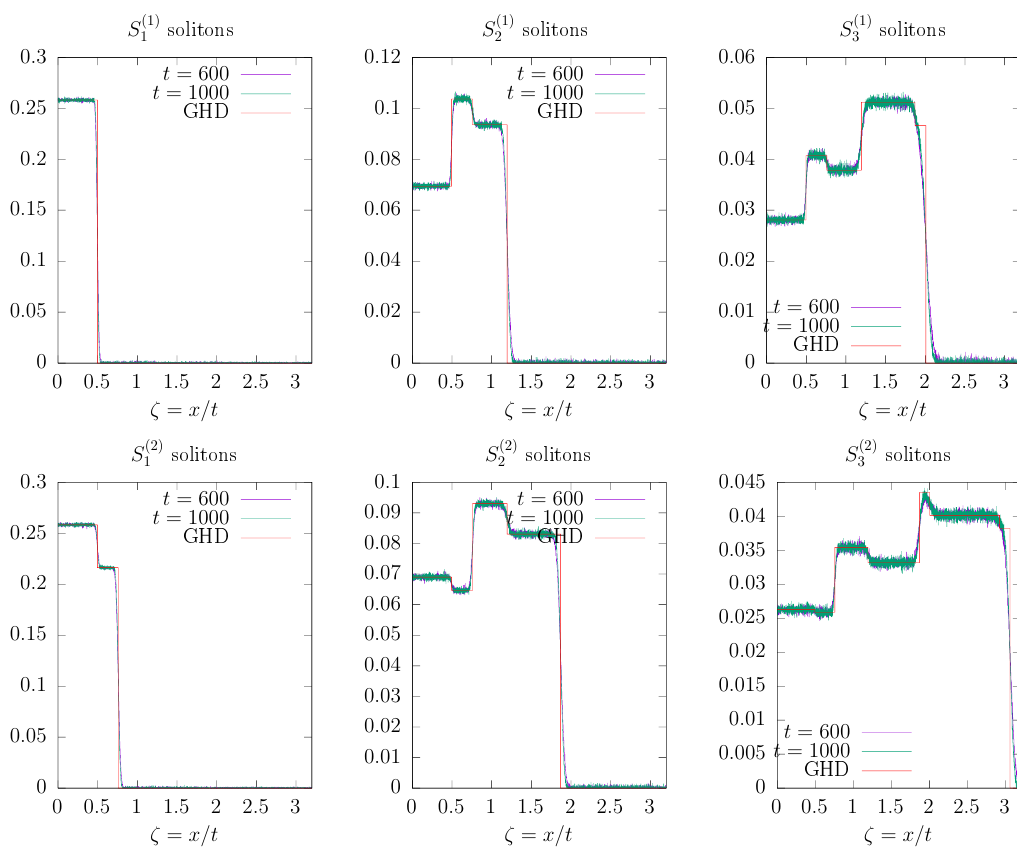
( a ) Figure 4: Numerical results for several S -soliton densities (with sizes k = 1 , 2 , 3 k and ‘color’ a = 1 , 2 ) as a function of ζ = x/t for t = 600 and t = 1000 and for (1) T (2) the T dynamics. The dotted lines indicate the GHD prediction for the l =100 l =100 step positions. The initial state is defined by the following fugacities in the left half: z 1 ,L = 1 z 2 ,L = 0 . 7 and z 3 ,L = 0 . 3 . The right half is initially in the vacuum state. Parameters of the simulations: system size L = 300000 and number of random initial = 300000 conditions N samples